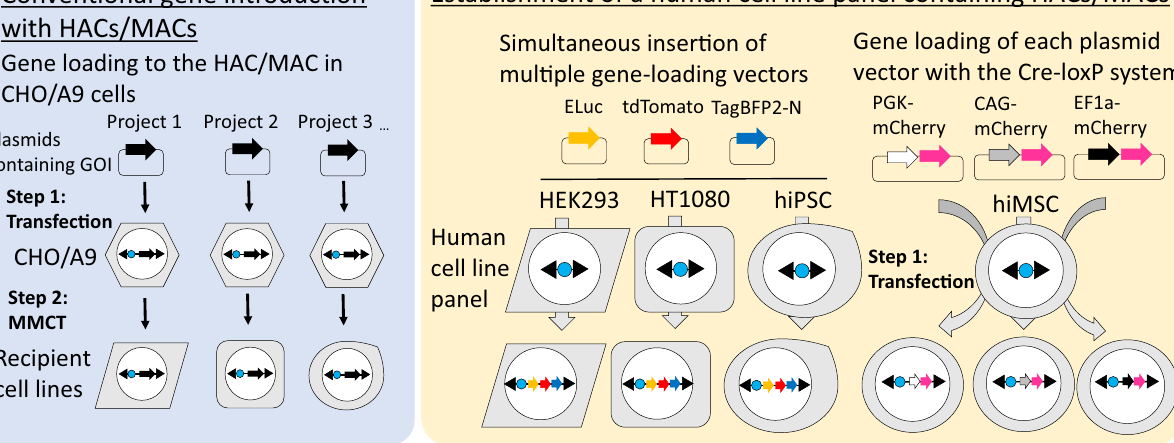
Figure 1. Schematic diagram of gene delivery via HACs/MACs. ( a ) Schematic diagram of the conventional gene-introducing strategy using HACs/MACs. In the conventional strategy, HACs/MACs for gene expression are constructed by transfection and insertion of the target gene(s) into the HAC/MAC in CHO or A9 cells that contain HACs/MACs as step 1. The constructed HACs/MACs are then introduced into target cells by MMCT as step 2. ( b ) Schematic diagram of the other gene-introducing strategy using the preprepared human cell panel with HACs/MACs. The HAC or MAC was transferred into representative human cell lines. The human cell line panel included HEK293 cells, HT1080 cells, human immortalised mesenchymal stem cells (hiMSCs), and human induced pluripotent stem cells (hiPSCs, 201B7). The human cell lines were directly available for gene loading into HACs/MACs with site-specific recombination. Simultaneous insertion of multiple gene-loading vectors into HEK293 cells, HT1080 cells, and hiPSCs (201B7) that contained HACs/MACs was tested by the SIM system. Each gene-loading vector of the SIM system contained Emerald luciferase (ELuc), a red fluorescent protein (tdTomato), or blue fluorescent protein (TagBFP2-N). hiMSCs that contained 21HAC2 were used to attempt insertion of three types of plasmid vectors that contained a red fluorescent protein (mCherry) driven by a different promoter with the Cre-loxP system. Each mCherry was expressed by a general constitutive promoter, e.g., PGK, CAG, or